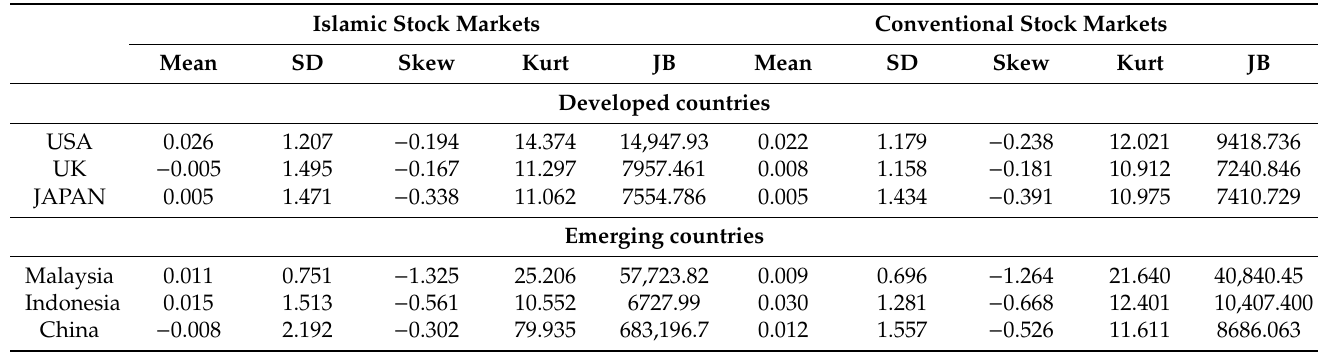
Table 2. Summary of the descriptive